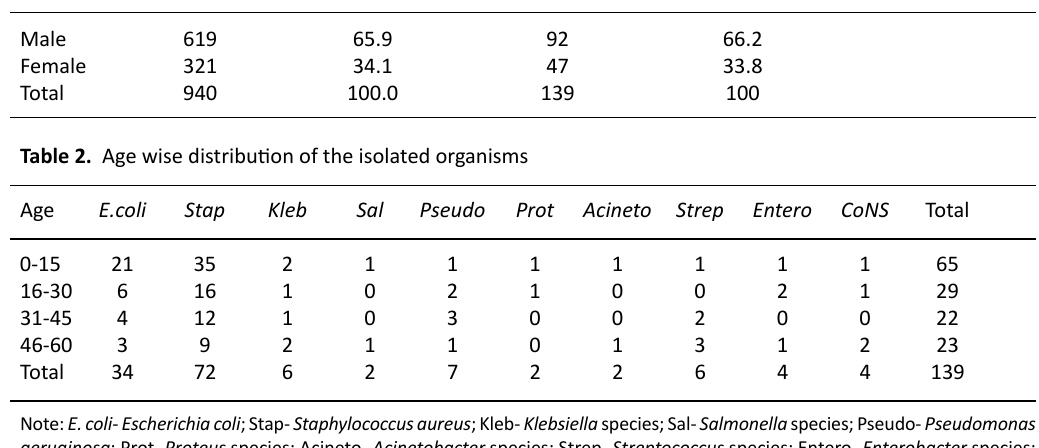
Table 1. Distribution of positive cases by gender Gender